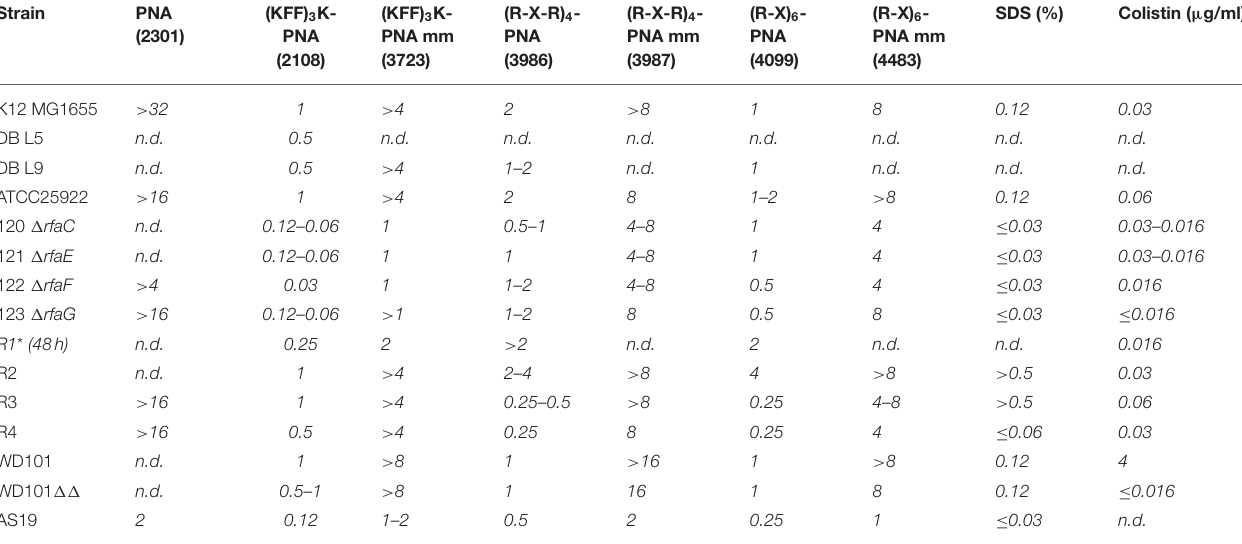
TABLE 2 | Minimum inhibitory concentration ( µ M) of BPP-PNA conjugates toward LPS mutant strains.